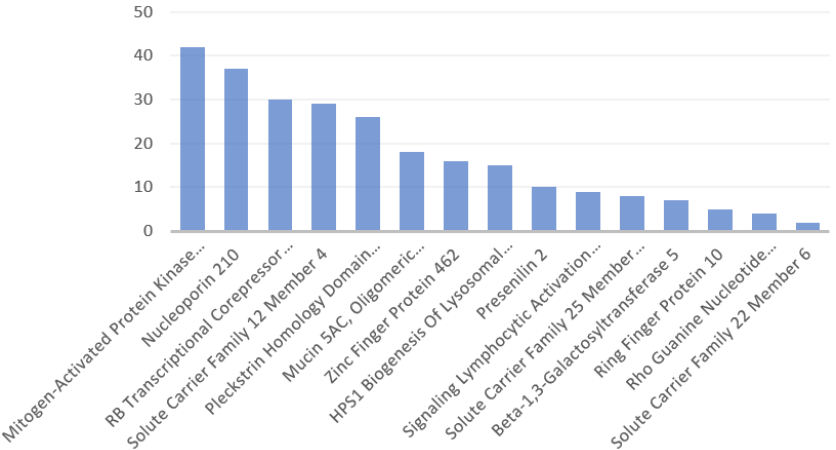
Figure 5. Number of tissues expressing the identified human proteins in descending order. The highest number of tissues express mitogen activated protein kinase kinase 3, compared to the expression of the other proteins with the respective data (Appendix A, Table A3).